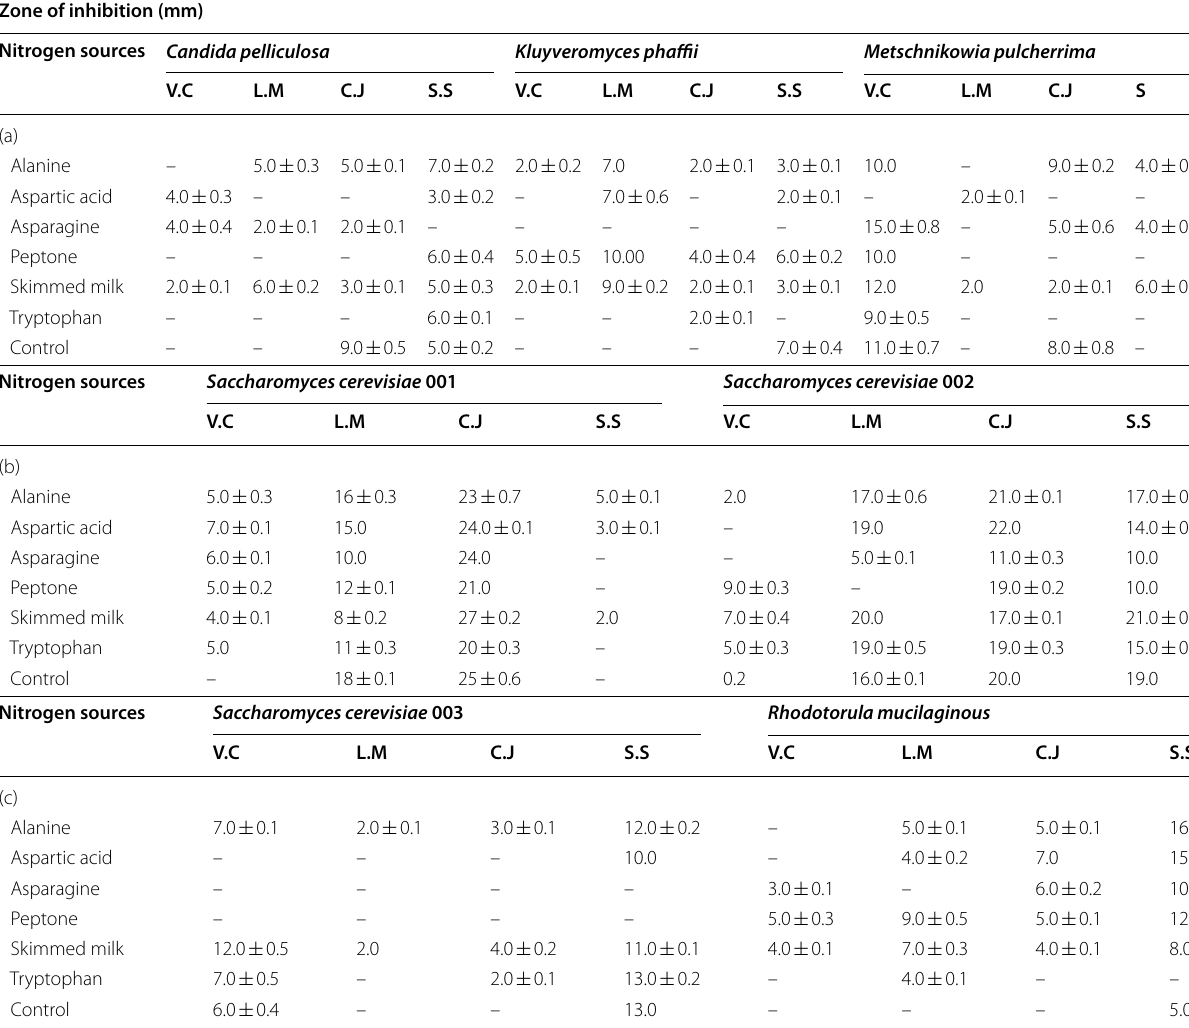
Table 8 Effect of nitrogen sources on the antimicrobial activities of (a) yeast species, (b, c) yeast isolates